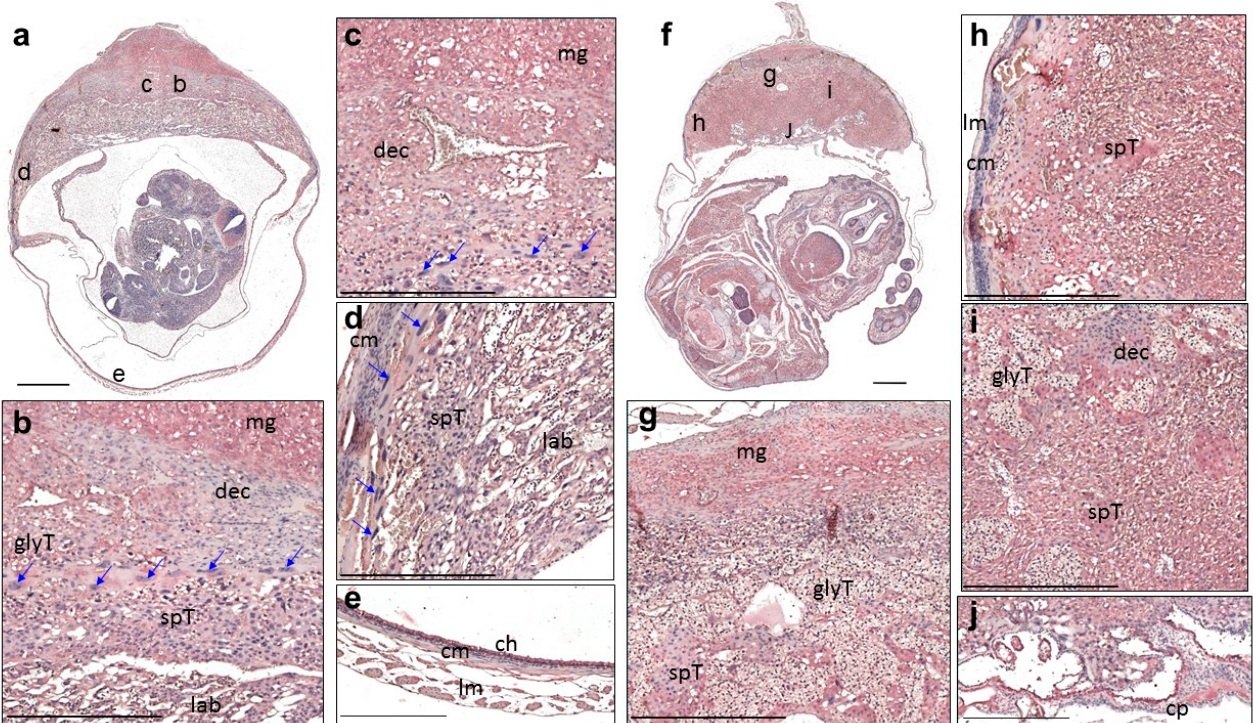
Figure 3. Expression of QSOX1 in the pregnant uterus and placenta at 13.5 and 17.5 dpc. ( a ) Representative image of immunohistochemical staining of QSOX1 at 13.5 dpc. ( b – e ) Enlarged views of the marked area in ( a ). ( f ) Representative image of immunohistochemical staining of QSOX1 at 17.5 dpc. ( g – j ) Enlarged views of the marked area in ( f ). The blue arrow indicates the parietal trophoblast giant cells. Red colors show QSOX1 staining, and blue shows the counterstain of hematoxylin in the nucleus. Scale bar = 500 μ m ( a ) and ( f ); 400 μ m ( b – e ) and ( g – j ). Abbreviations: ch, chorion; cm, circular muscle; cp, chorionic plate; dec, decidua; glyT, glycogen trophoblast; lab, labyrinth; lm, longitudinal muscle; mg, mesometrial gland; spT, spongiotrophoblast.